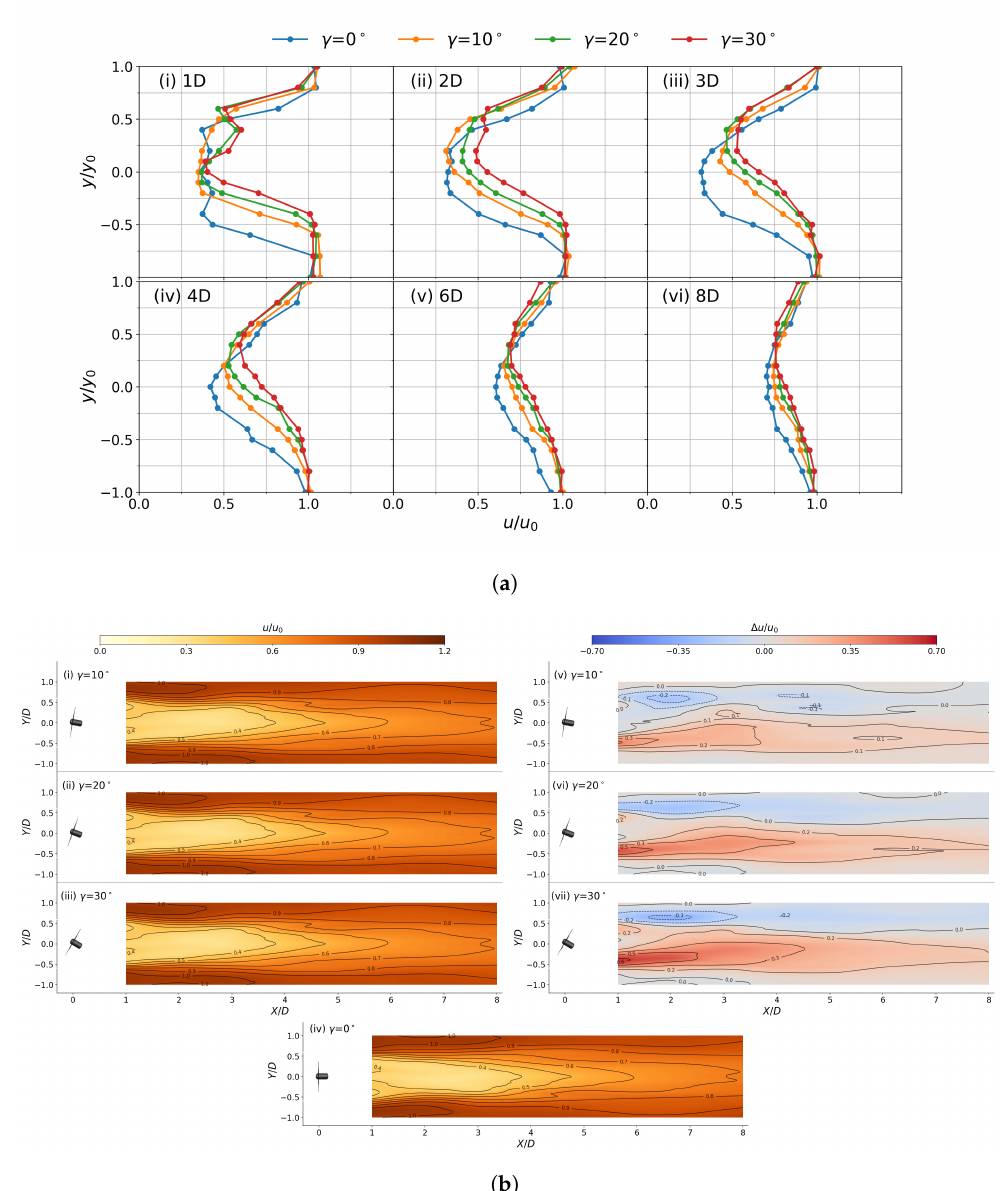
Figure 6. Wake velocity profiles for Scenario 1. ( a ) Normalised velocity distribution for the four cases of Scenario 1 at six downstream cross-sections. The separation distance between the profiles and the turbine are (i) 1 D , (ii) 2 D , (iii) 3 D , (iv) 4 D , (v) 6 D , and (vi) 8 D , respectively. ( b ) Normalised turbine wake velocity distributions for the cases of Scenario 1 and relative differences in normalised velocity between yawed and non-yawed turbine configurations: (i) u / u 0 = u γ = 10 ◦ / u 0 , (ii) u / u 0 = u γ = 20 ◦ / u 0 , (iii) u / u 0 = u γ = 30 ◦ / u 0 , (iv) u / u 0 = u γ = 0 ◦ / u 0 , (v) ∆ u / u 0 = ( u γ = 10 ◦ − u γ = 0 ◦ ) / u 0 , (vi) ∆ u / u 0 = ∆ u / u ( u − u ) / u = ( u − u ) / u γ = 20 ◦ γ = 0 ◦ γ = 30 ◦ γ = 0 ◦ 0 , and (vii) 0 0